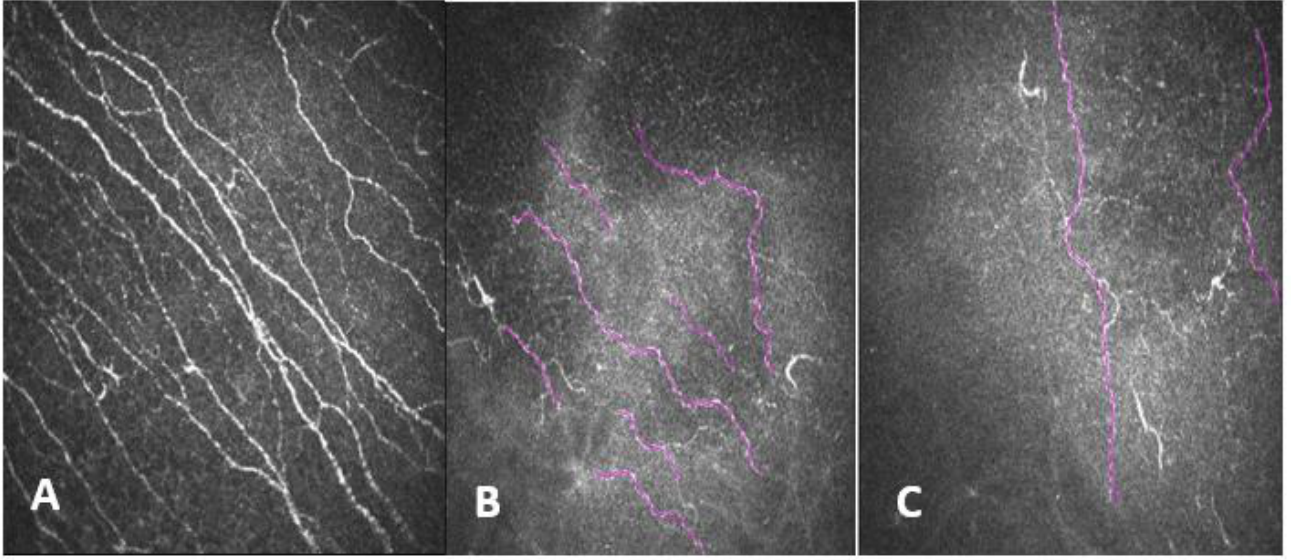
Figure 8. ( A ) Corneal nerve plexus in a patient without systemic pathologies and without refractive surgery. ( B and C ) Corneal nerve plexus in right eye and left eye of a patient with small fiber neuropathy.